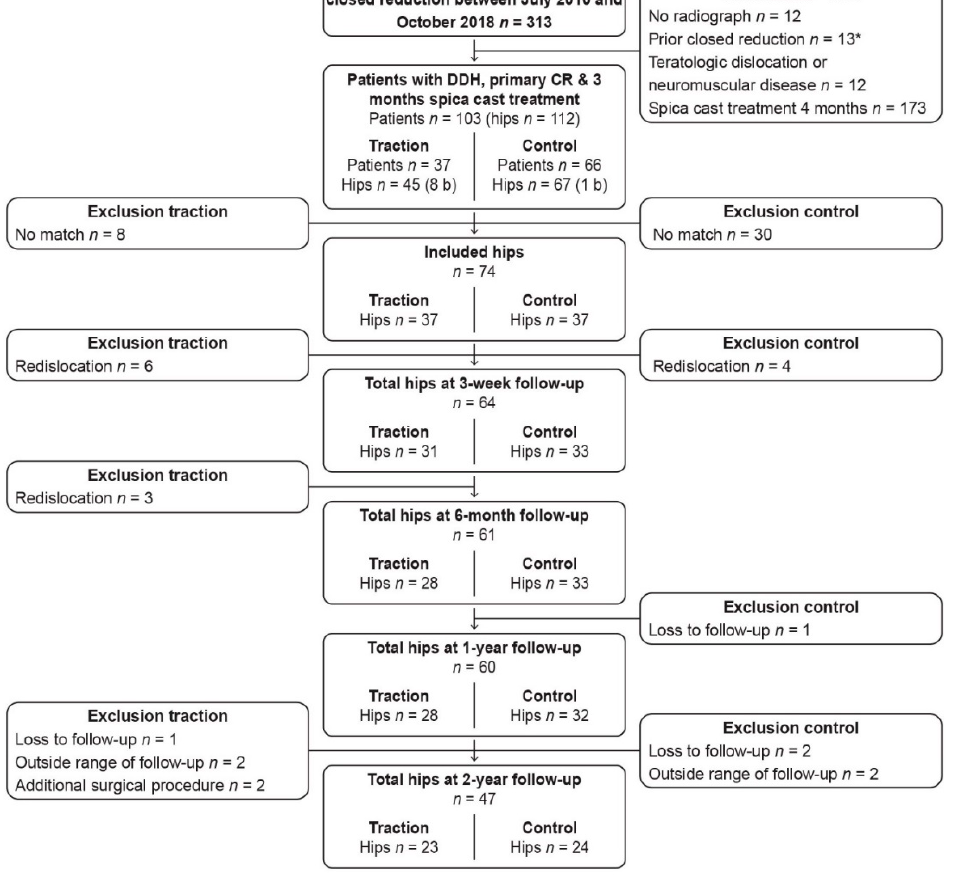
Figure 1. Flowchart of patient inclusion and follow-up. DDH = developmental dysplasia of the hip; CR = closed reduction; n = number; b = bilateral. * Patients with a closed reduction in the medical history were